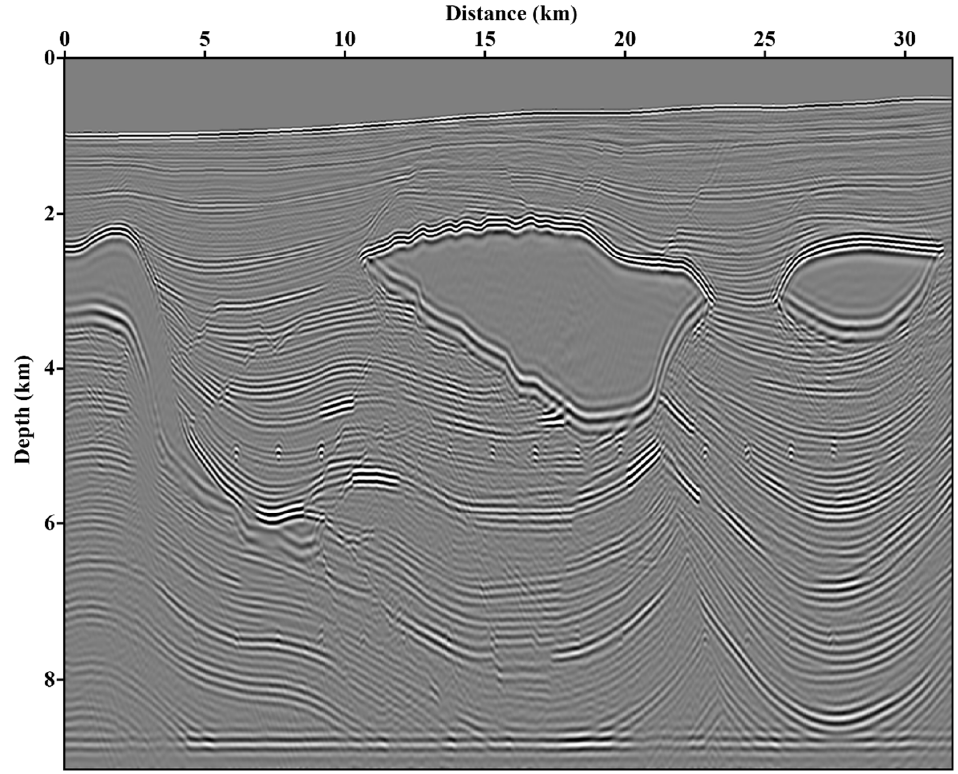
Figure 11. The LSRTM (six iterations) image with the inaccurate wavelet.